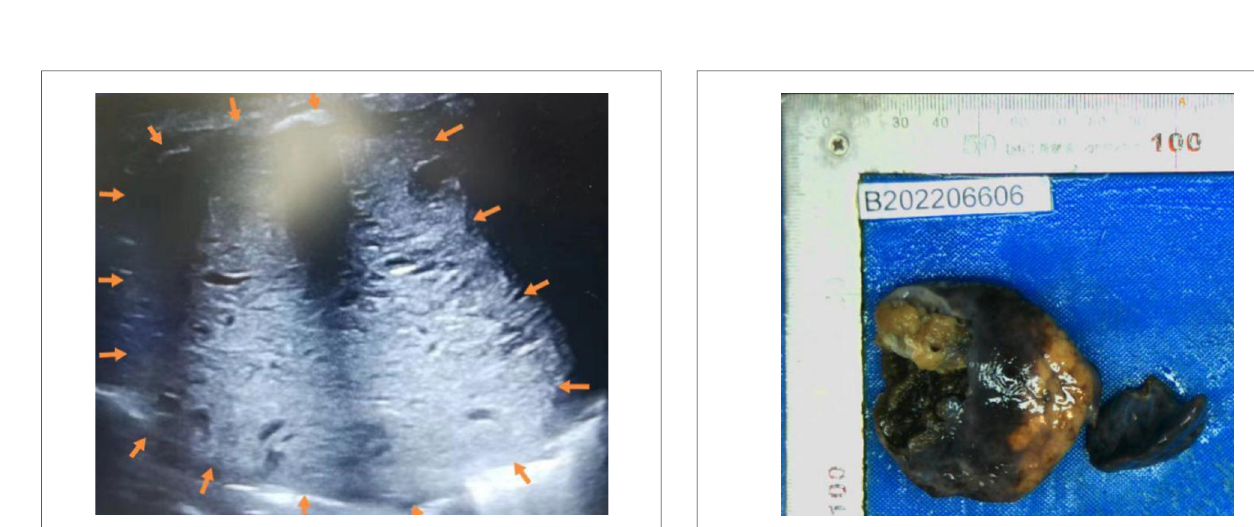
FIGURE 3 Postnatal ultrasound showing a well-circumscribed, isoechoic mass (arrows) (5.7×5.5×6.1 cm 3 ) with anechoic cystic spaces.